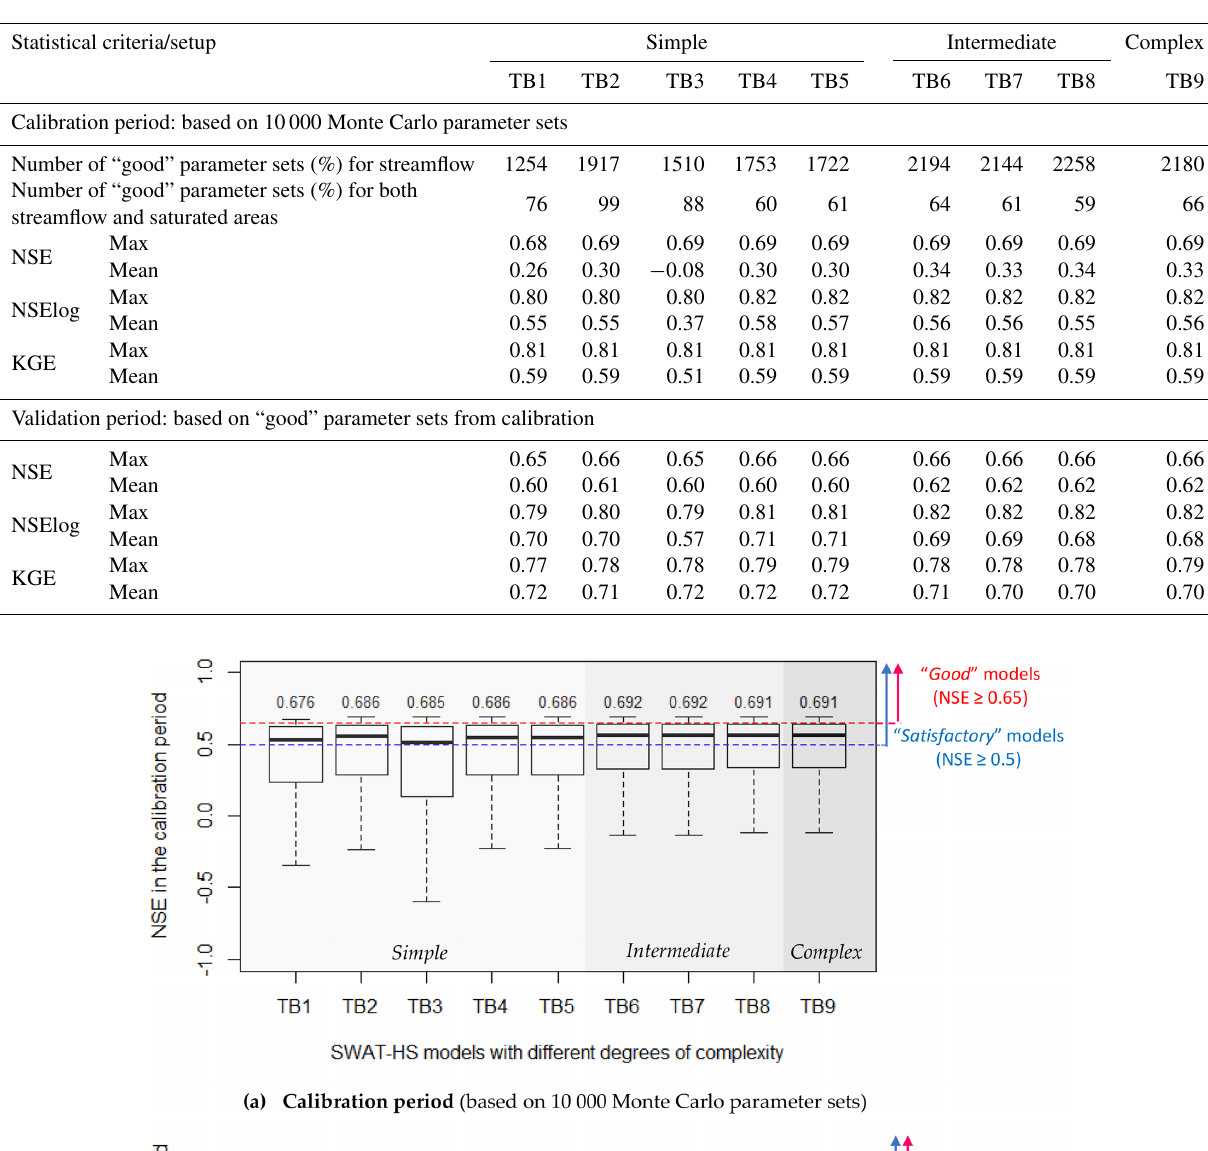
Table 4. Statistical criteria to compare the effect of input complexity on model uncertainty.